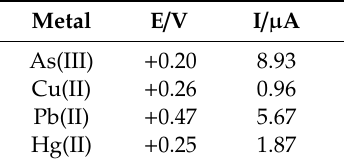
Table 2. SWASV signal for As(III), Cu(II), Pb(II), Hg(II) solution in 0.1 M HCl in the potential